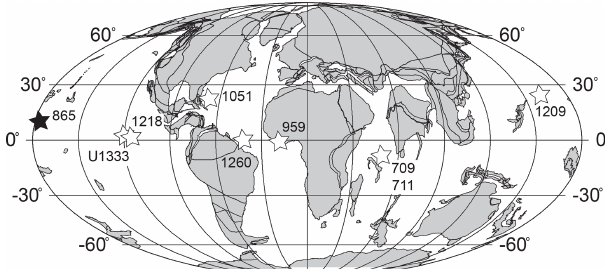
Figure 1. Location map for ODP Site 865 (solid star) and other low-latitude sites discussed in the main text (open stars) on a 40Ma reconstruction. Palaeolatitudes for each site are calculated from van Hinsbergen et al. (2015). Base map generated from http: //www.odsn.de (last access: 8 June